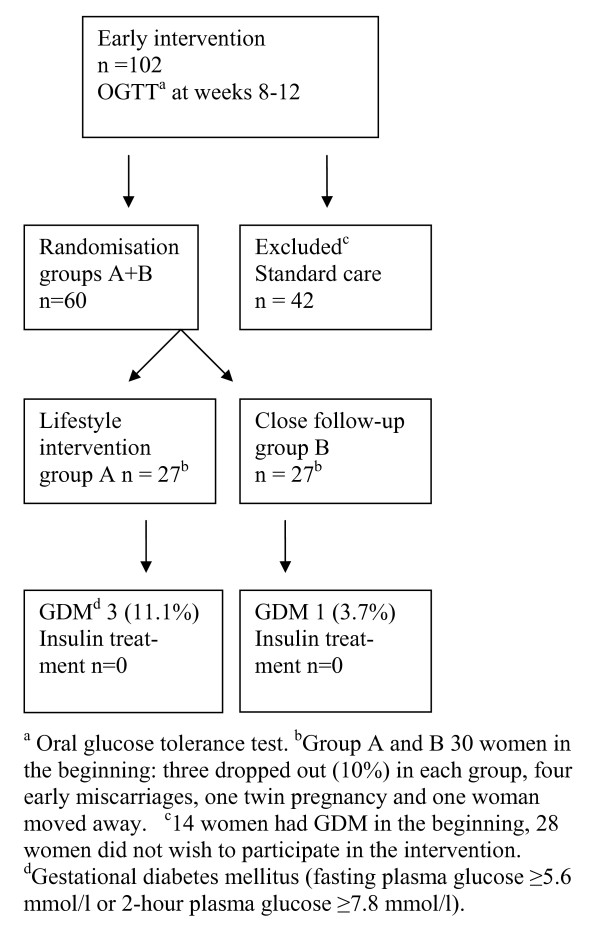
Formation of the study populations.